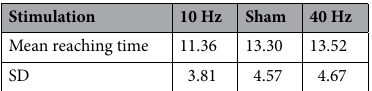
Table 3. Time to reach the fifth word.